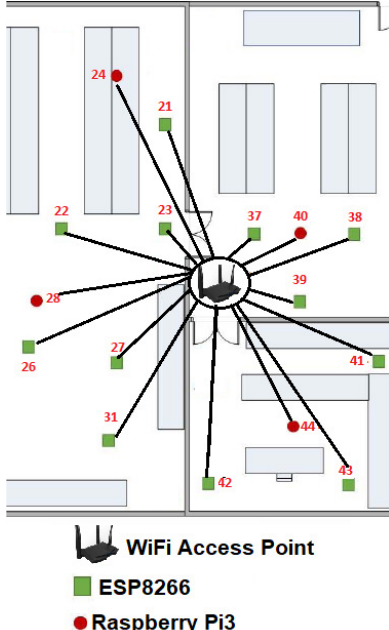
Figure 10. Experiments: reliable WSN N ( t 0 ) development boards by the wireless access point (WAP) Tenda AC1200.